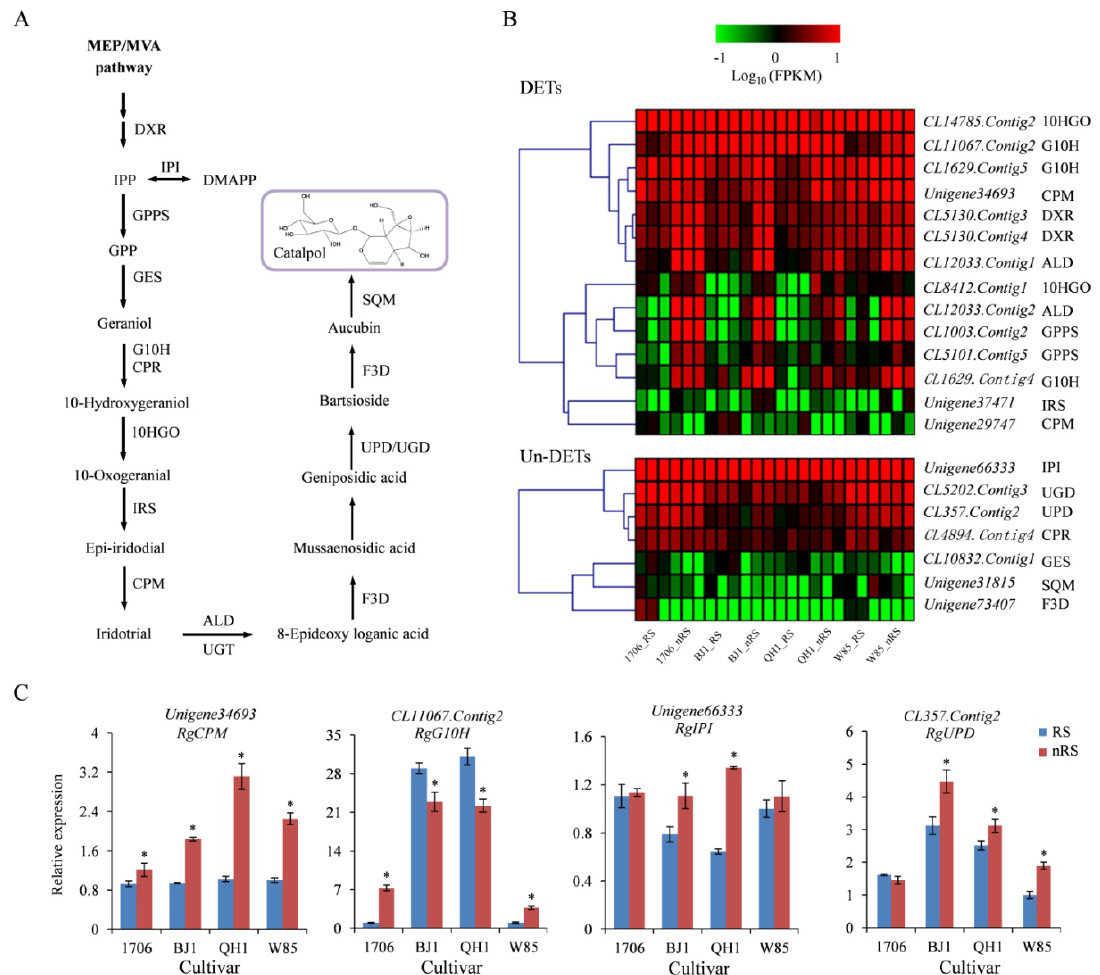
Figure 6. Expression patterns of catalpol biosynthetic unigenes between radial striations and non-radial striations of R. glutinosa . ( A ) Biosynthetic pathway of catalpol. ( B ) Heat map representing expression dynamics of unigenes involved in biosynthesis. The expression values (FPKM) for unigenes were log 10 transformed and scaled across each row, and the heatmap was generated by MultiExperiment Viewer (MeV). ( C ) Relative expression of candidate genes in involved in catalpol biosynthesis. These genes expression levels were all determined by Real-time PCR (qRT-PCR). Vertical bars indicate the standard deviation of three biological replicates. Asterisks (*) indicate a significant difference at the p < 0.05 level. Abbreviations: DXR, 1-deoxy-D-xylulose 5-phosphate reductoisomerase; GPPS, geranyl diphosphate synthase; IPI, isopentenyl-diphosphate Delta-